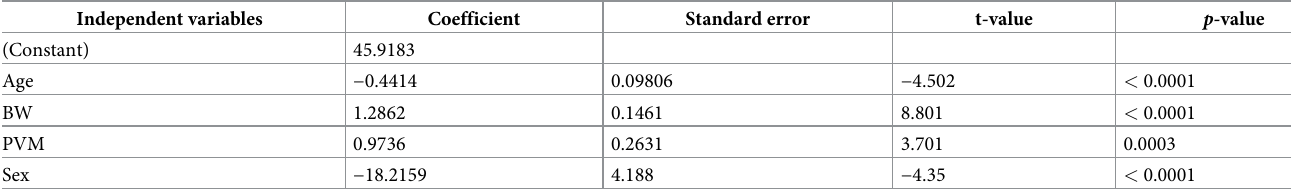
Table 3. Summary of regression